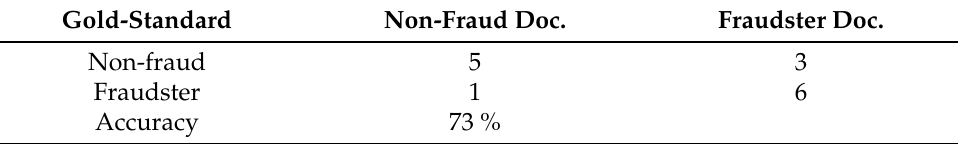
Table 4. Lexical-analysis classifier results: confusion matrix and accuracy with the held-out test set. Gold-Standard Non-Fraud